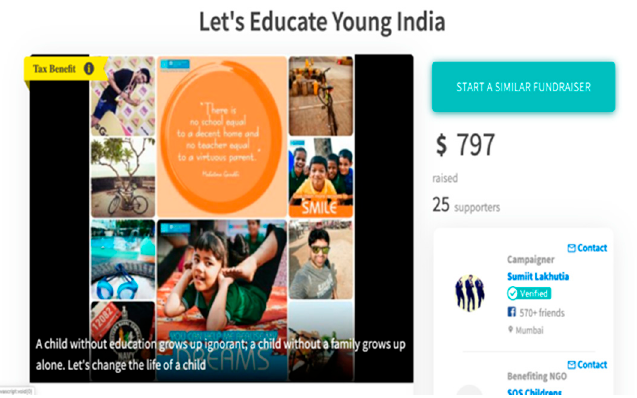
Figure 1. Screenshot of a campaign from Ketto. Source: https://www.ketto.org/fundraiser/lovedandeducated (accessed on 8 March 2021).